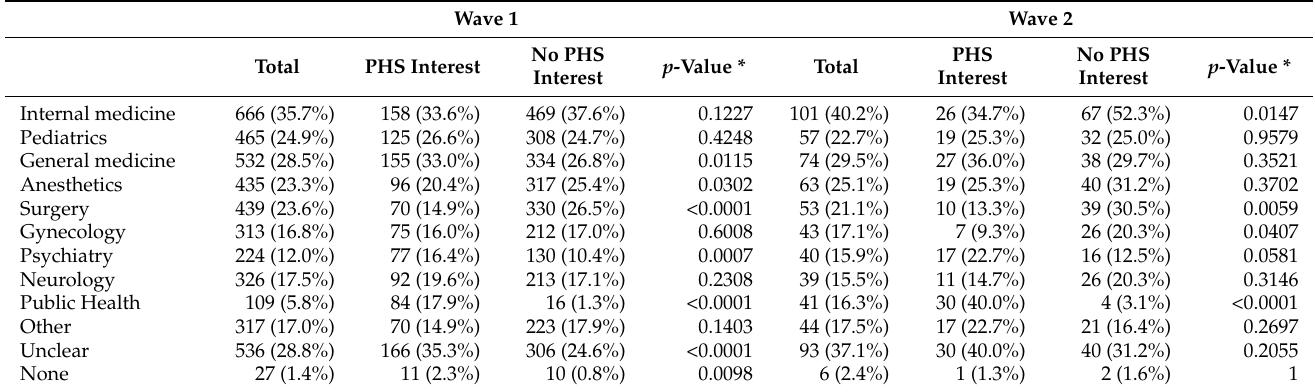
Table A9. Medical specialist training programs that are generally considered as options for medical students, according to their PHS interest: Absolute and relative proportions, taking into account multiple responses in waves 1 and 2,